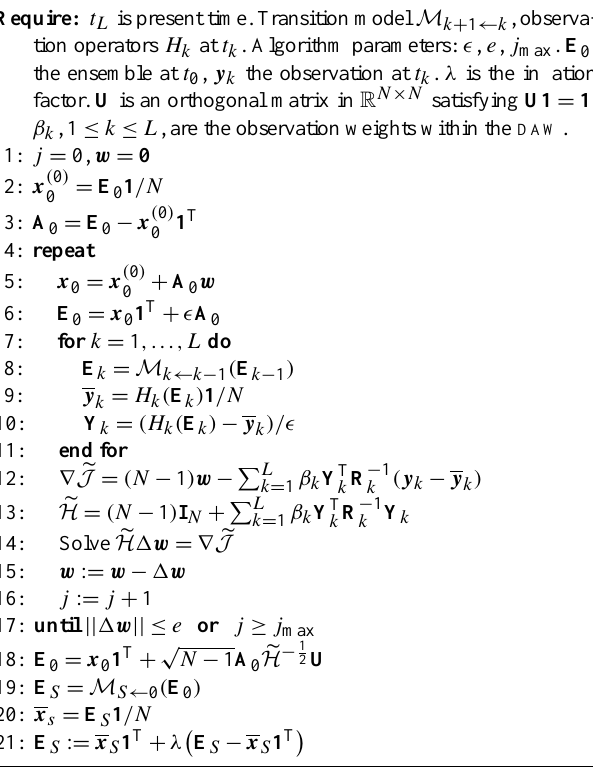
Algorithm 1 A cycle of the lag-L / shift-S / MDA / bundle / Gauss-Newton IEnKS.